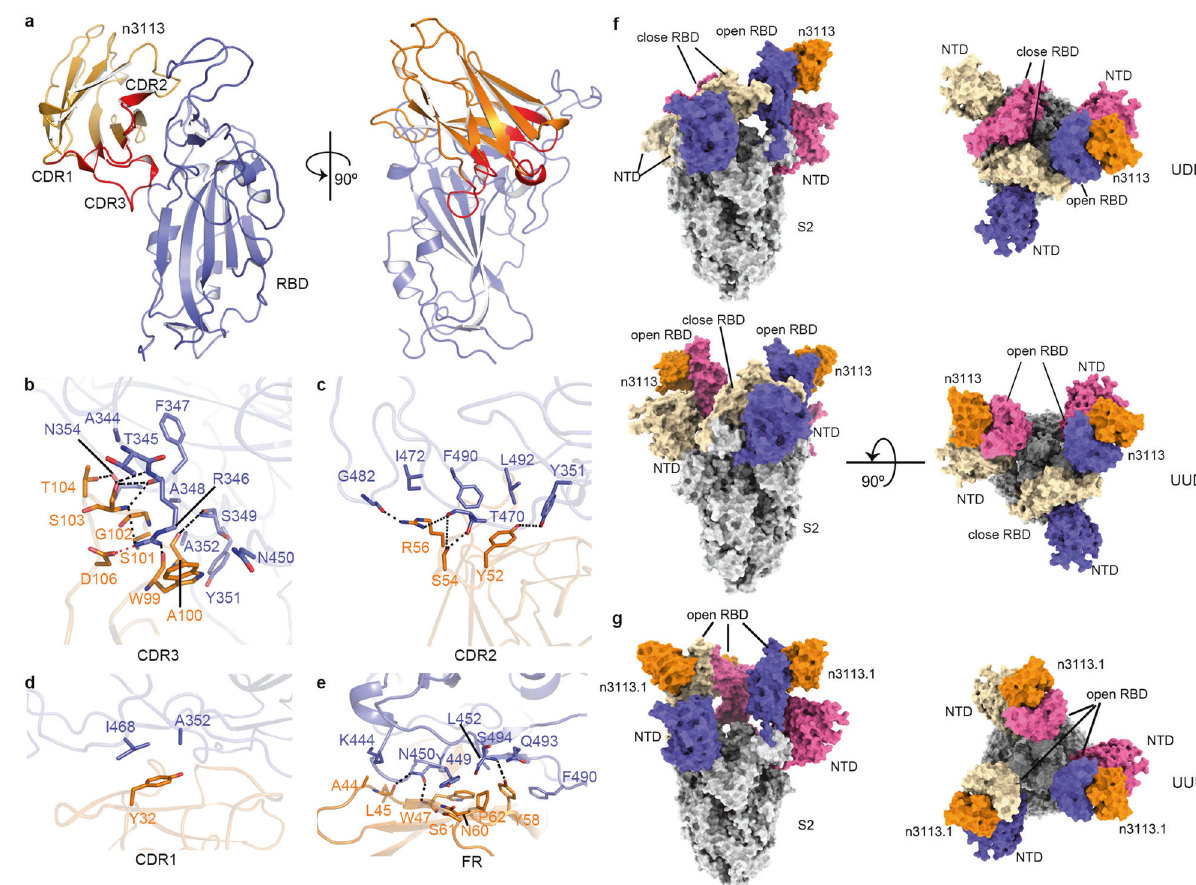
Fig. 2 Structural features of n3113 and n3113.1 in complex with RBD and spike ectodomain. a – e Crystal structure of RBD-n3113. a Overall structure of RBD-n3113. The RBD is shown in a blue cartoon. N3113 is presented in an orange cartoon with its three CDRs highlighted in red. b – e Detailed interactions between CDR3 ( b ), CDR2 ( c ), CDR1 ( d ), and FR ( e ) of n3113 and RBD. The residues involved in binding are shown in blue (n3113) and orange (RBD) sticks. Salt bridge and hydrogen bonds are shown as red and black dashed lines, respectively. f , g Cryo-EM structures of spike ectodomain with n3113 ( f ) and n3113.1 ( g ) Two perpendicular views of UDD-, UUD- and UUU-state complex are shown as surface. S2 subunit of S trimer is rendered in grey. The S1 (NTD and RBD) subdomains from each monomer are colored in blue, pink, and brown, respectively. N3113 and n3113.1 are colored in protein-mediated cell-cell fusion assay 41,42 (Fig. 3f). 293 T cells transiently transfected with SARS-CoV-2 S protein and GFP were incubated with target Huh7 cells that endogenously express ACE2 or 293 T cells engineered to express ACE2 at their surface for 48 h. Large syncytium with multiple nuclei was observed in fused cells, due to the S protein-mediated membrane fusion. Pretreatment of effector 293T-S cells with 10 μ M n3113.1 had moderate prevention for syncytia formation. However, n3113.1-Fc and S309 prevented the cell-cell fusion profoundly. The inhibition potency of these two antibodies is comparable with that of CB6. These data indicated that n3113.1 and S309 can block viral entry into healthy cells through inhibiting SARS-CoV-2 fusion with the target cells.